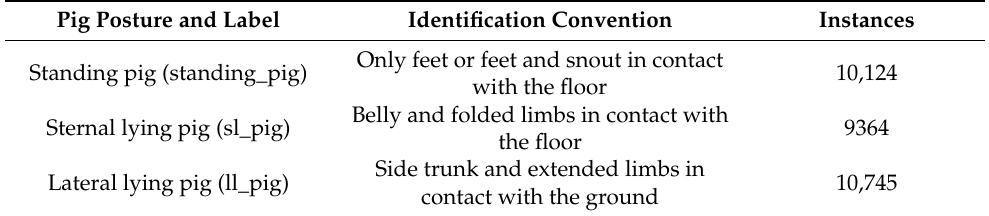
Table 1. Pig posture categories and their convention used to classify them in human annotation. Pig Posture and